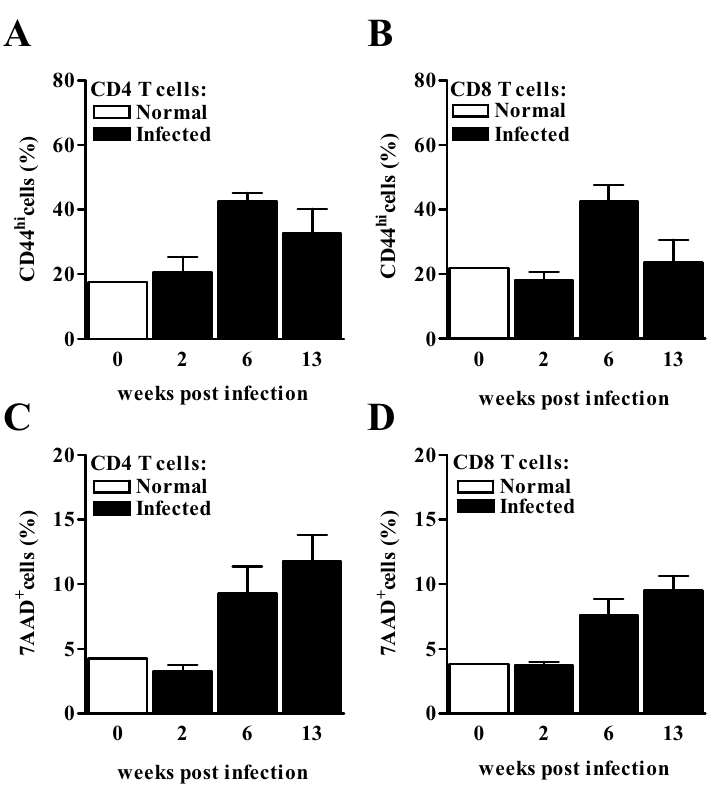
Fig. 1 – T cell activation and apoptosis during L. major infection. Lymph node cells from normal and L. major -infected mice were analysed by flow cytometry. Activation of CD4 (A) and CD8 (B) T cells was determined by high expression of CD44. Apoptosis was assed upon staining with 7-AAD in CD4 (C) and CD8 (D) T cells. Open bars represents T-cell activation and apoptosis in a pool of (inguinal and popliteal) lymph nodes from normal mice, black bars represent draining (popliteal) lymph nodes from L. major -infected mice. Results are expressed as average and SEM (n=2-3